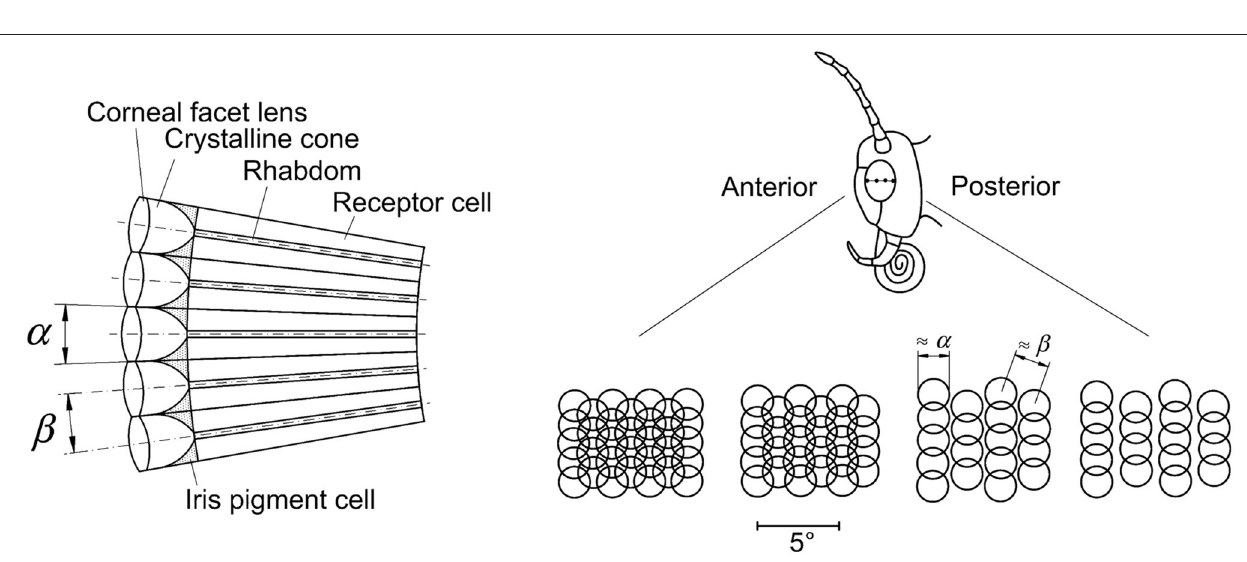
As smooth surfaces are required in the here proposed facet optics, fused filament fabrication is not an